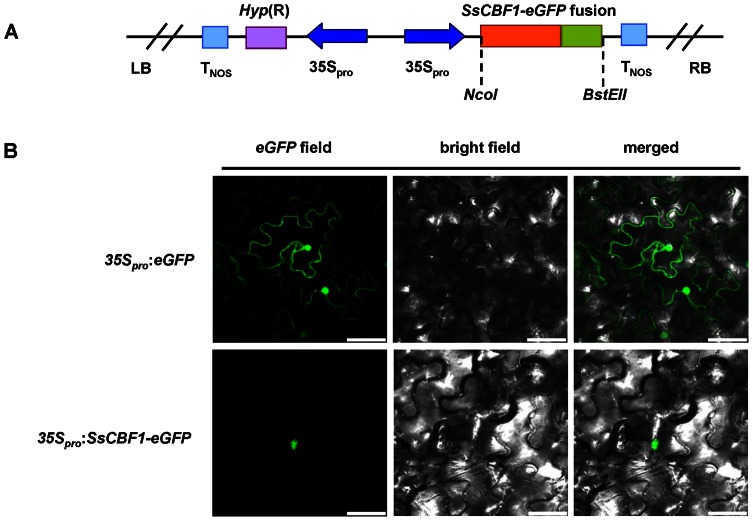
Subcellular localization of SsCBF1-eGFP fusion protein.(A) Schematic representation of 35Spro:SsCBF1-eGFP construct used for transient expression in N. benthamiana leaves. (B) Subcellular localization assay of SsCBF1-eGFP fusion protein. N. benthamiana leaves transiently expressing eGFP alone (upper) and SsCBF1-eGFP (bottom) proteins were observed with a confocal microscope. Bars  = 50 µm.